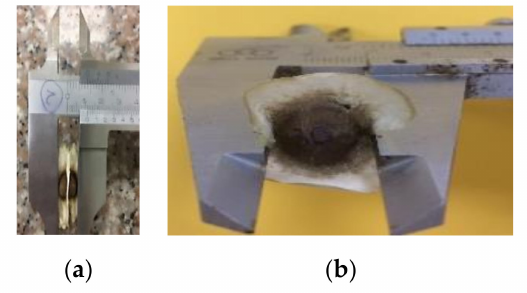
Figure 1. Dimensions of moringa seeds ( a ) width; ( b )